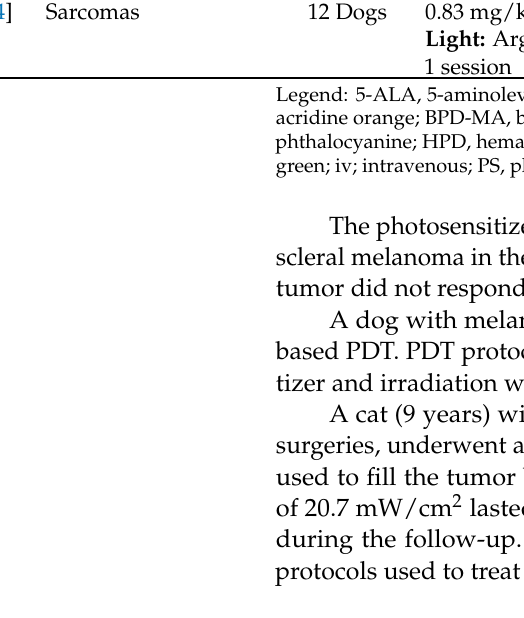
Table 4. Clinical studies on PDT in animals with